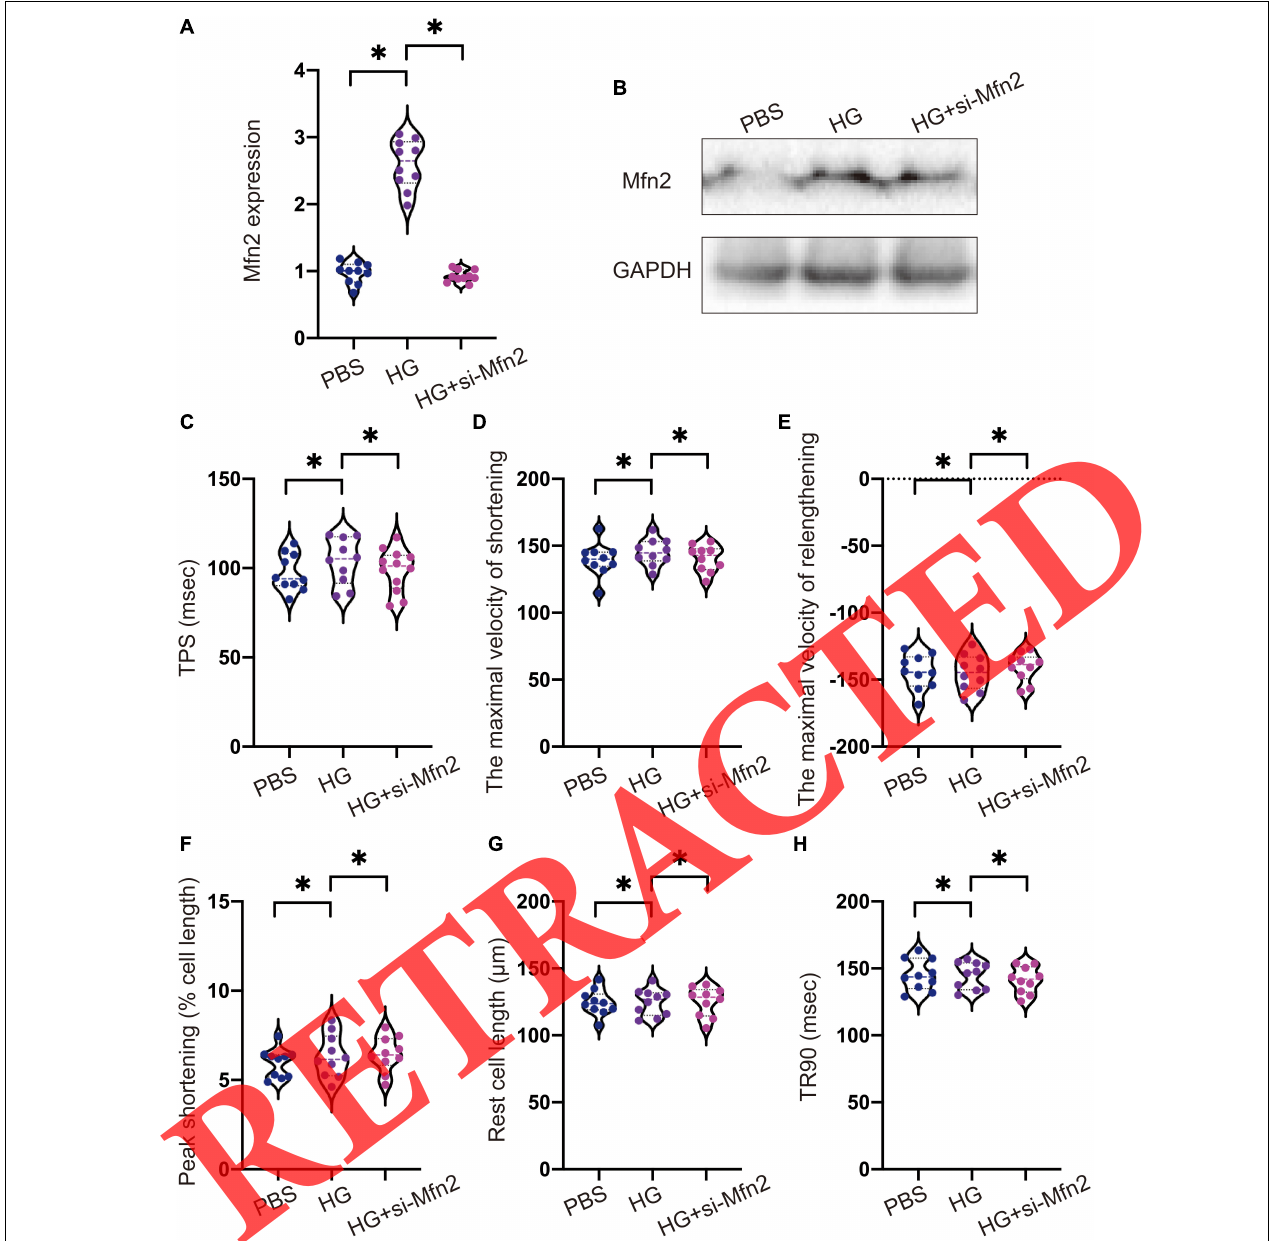
FIGURE 1 | Mfn2 silencing protects cardiac function under hyperglycemic conditions. (A,B) Western blotting was used to analyze Mfn2 expression in cardiomyocytes under hyperglycemic conditions. (C–H) The contractile properties of cardiomyocytes were determined using Fura-2AM. + dL/dt , maximal velocity of shortening; -dL/dt , maximal velocity of re-lengthening; TPS , time to peak shortening; TR90 , time to 90% re-lengthening. ∗ p <